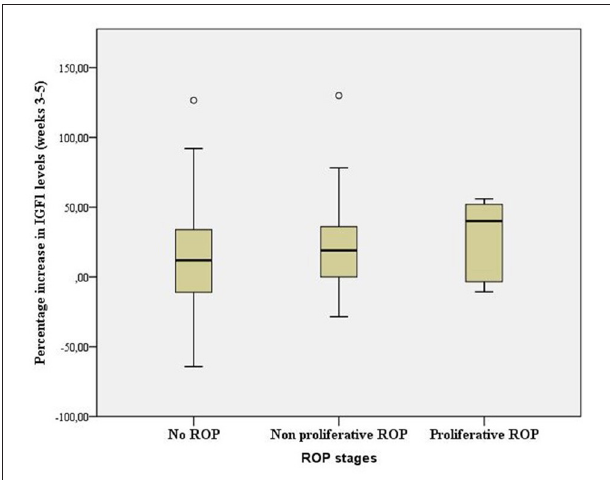
FIGURE 2 | Box plot showing range, quartile 1, quartile 3, and median percentage increase in IGF1 levels between weeks 3 and 5 of life according to ROP grade ( p > 0.05,